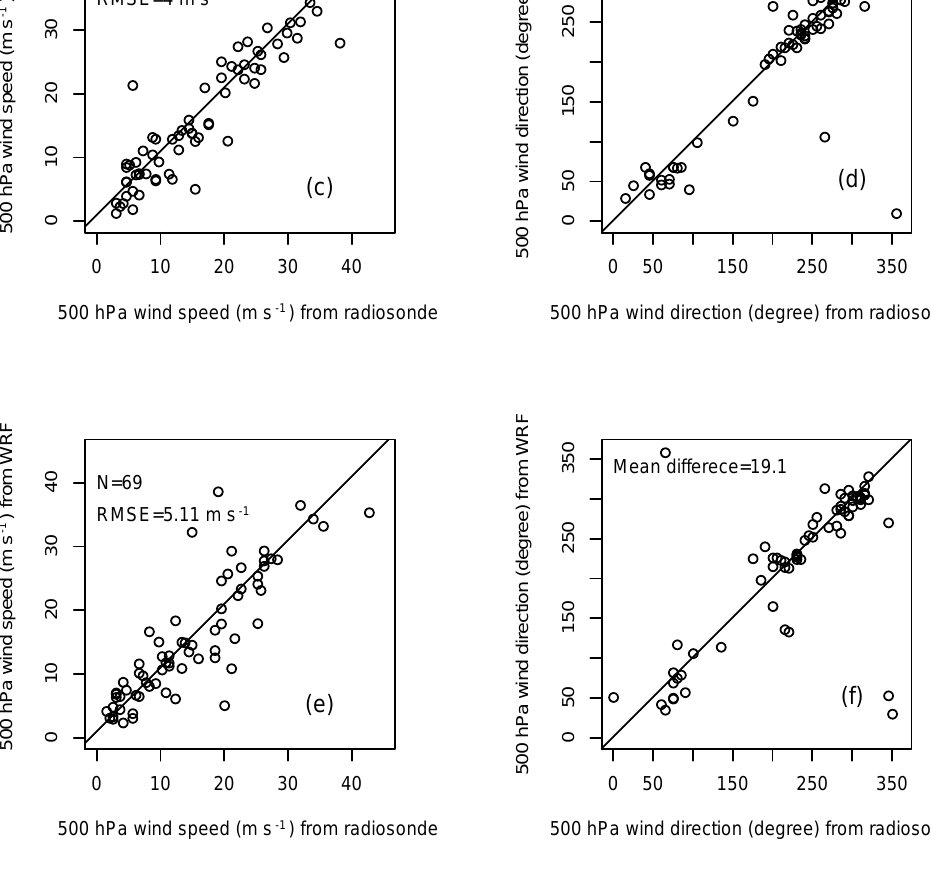
Figure 7. Comparison of 500hPa wind speed and wind direction between WRF simulation and radiosonde measurements. Panels (a) and (b) are the comparison on 2 June 2011 at 00:00UTC; panels (c) and (d) are on 2 June 2011 at 12:00UTC; and panels (e) and (f) are on 3 June 2011 at 00:00UTC. RMSE and relative error (RE) for wind speed and mean difference in wind direction are shown in each